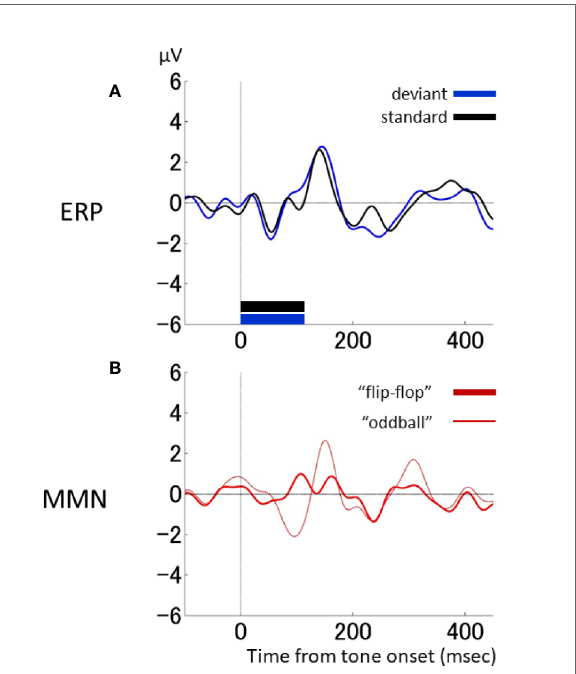
FIGURE 4 | Responses to 100-ms-duration stimuli in different contexts. (A) , Response by one macaque monkey (monkey F) to 100-ms stimuli in a standard context (standard condition in the “ fl ip- fl op ” paradigm: black) and a deviant context (deviant condition in the original oddball paradigm: blue). (B) , Comparison of differential waveforms using ERPs to the standard stimulus in the original oddball paradigm (thin line: same as ) and ERPs to the standard stimulus in the fl ip- fl op paradigm (thick